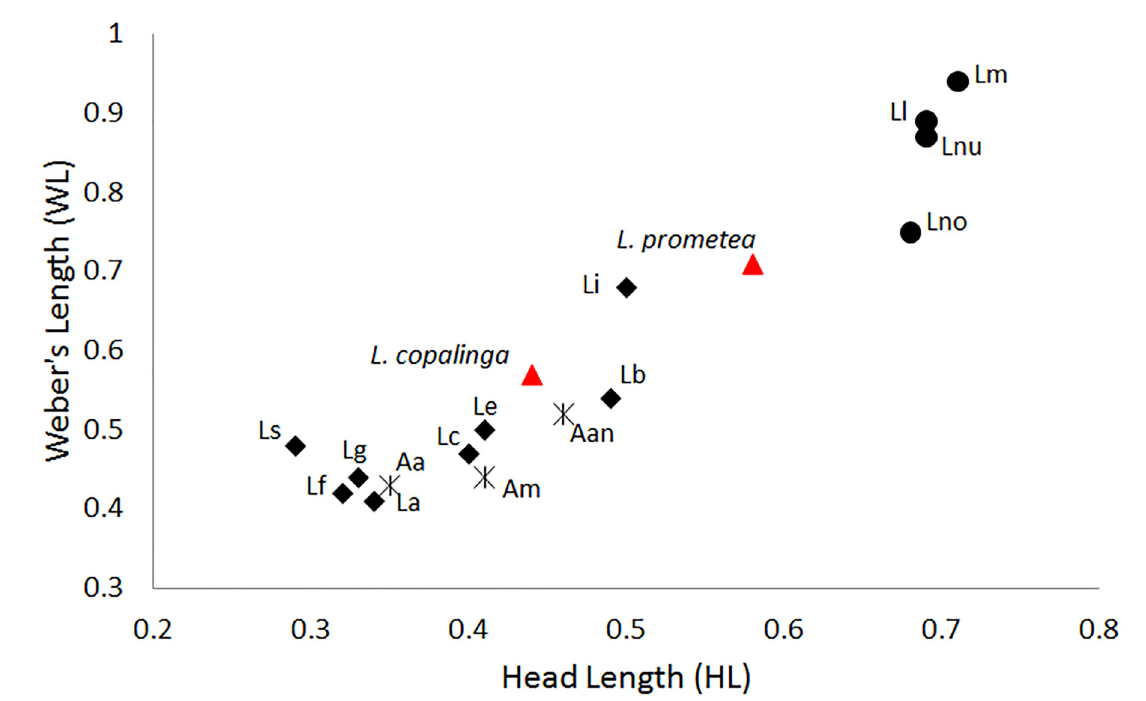
Fig. 1. Relationship between HL and WL among workers in species of Leptanilloides and Asphinct- anilloides . Specimens measured are holotypes or paratypes. Measurements are in mm. WL is called Mesosoma Length (ML) in Borowiec & Longino (2011) and Silva et al. (2013). Triangles: the two Leptanilloides described in this paper ( L. copalinga Delsinne & Donoso sp. nov. and L.